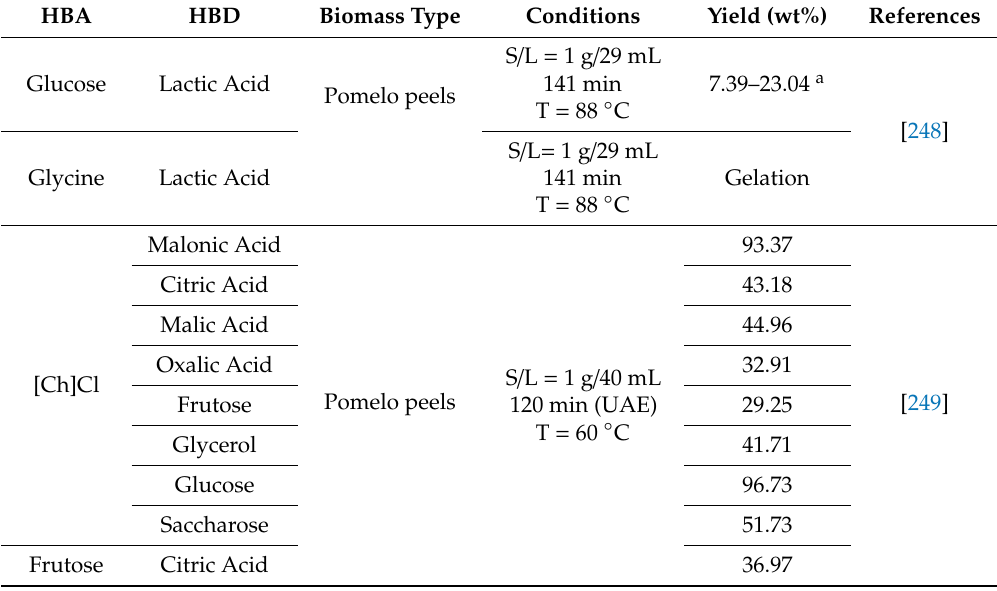
Table 9. DESs reported to extract pectin, pectin yield and experimental conditions applied.